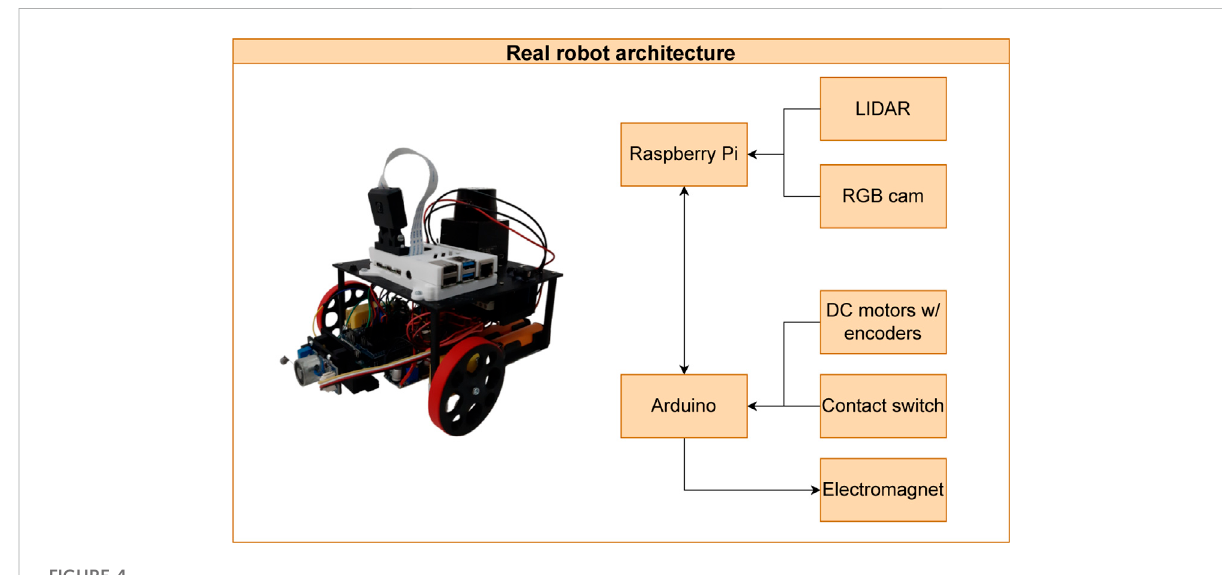
FIGURE 4 AMR and its components Braun et al.